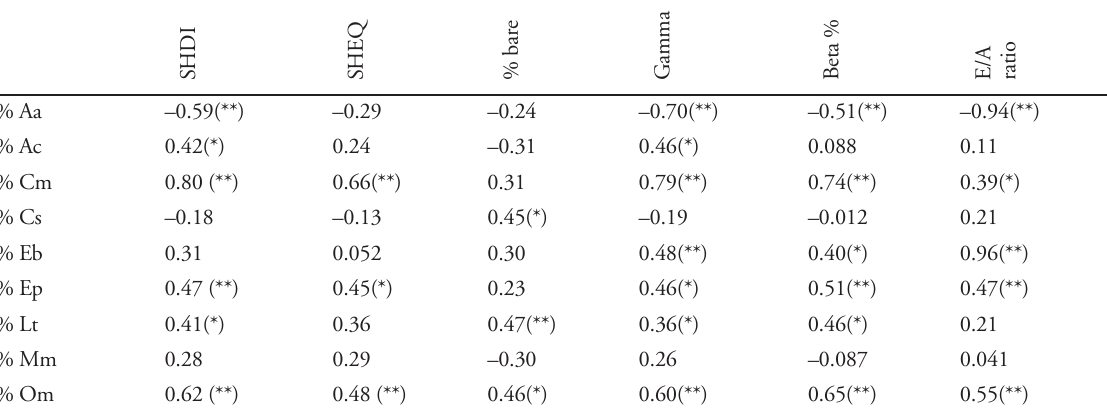
Table 3. Correlations (Spearman’s rho) among vegetation attributes of the 30 profiles. Notice the general pattern of positive correlations between variables, except in the case of relative abundance of Ammophila arundinacea . (**) = p < 0.01, (*) = p < 0.05.